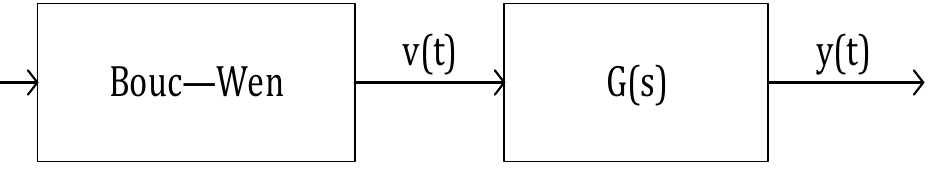
Figure 2. The structure of the classic Hammerstein model.